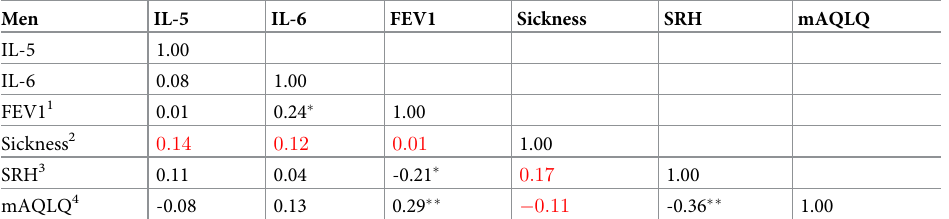
Table 5. Spearman’s correlations for changes in cytokines, FEV1, sickness behaviour, asthma-related quality of life and self-rated health between baseline and follow-up in